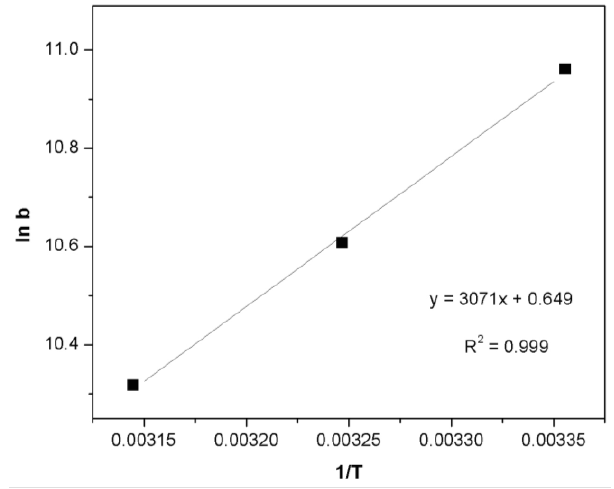
Figure 8. Van’t Hoff plots to get the  H° and  S° of the Orange II adsorption over